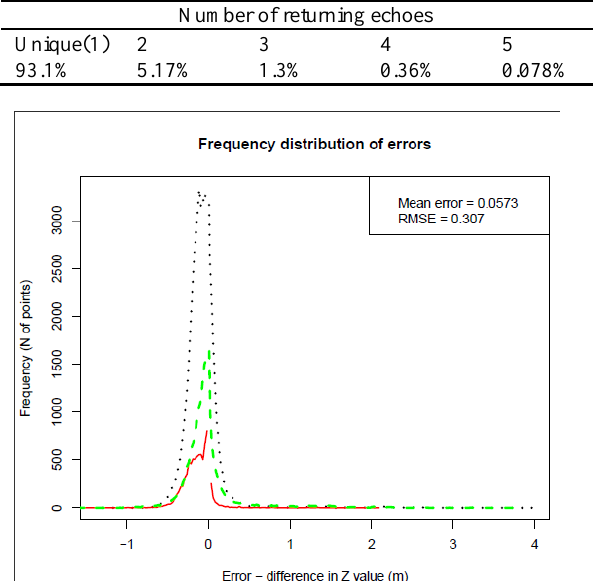
Table 3. Percent of points per returning echoes Number of returning echoes